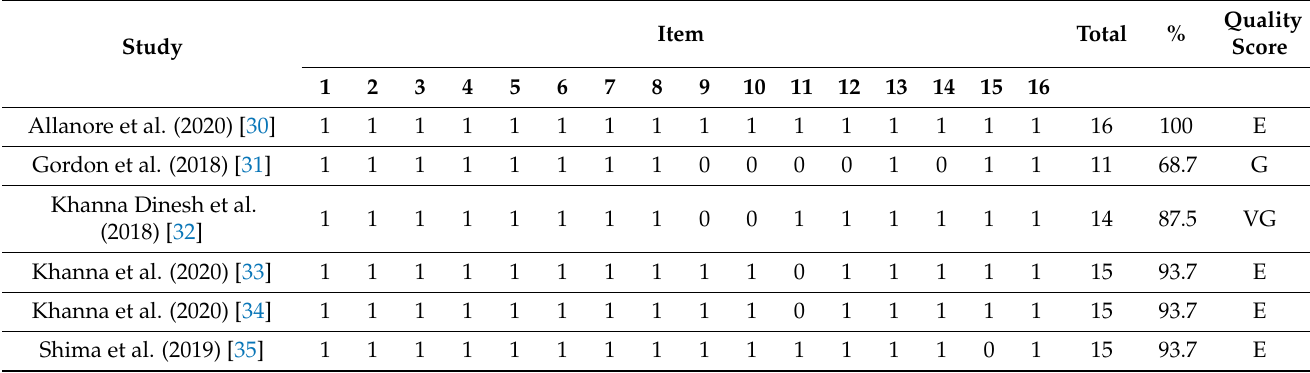
Table A1. Results of the methodological quality assessment of included studies—McMaster Critical Review Form for Quantitative Studies [28].